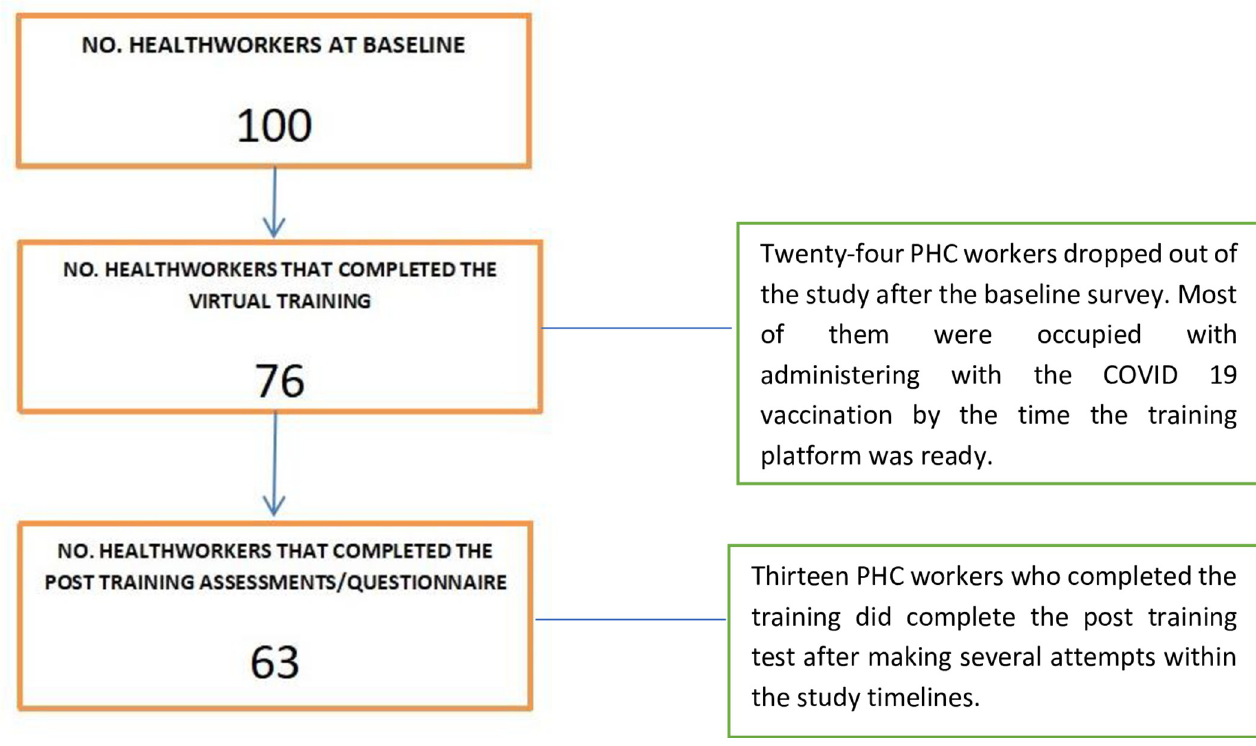
Fig 1. Study flow chart for PHC